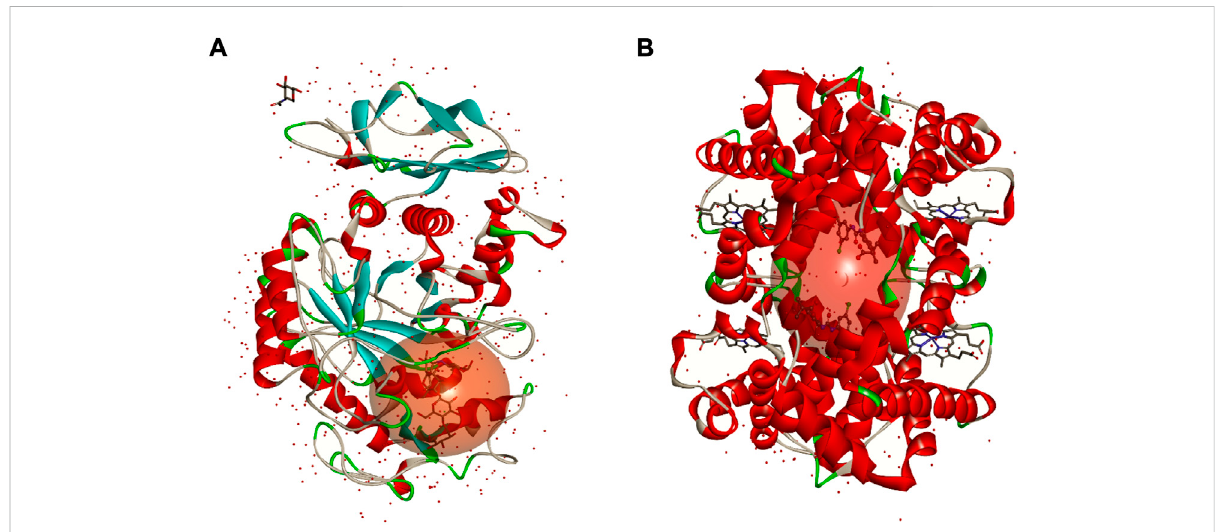
FIGURE 4 3D structures of α -amylase (A) and human haemoglobin (B) . The sphere in red represents the active site of each protein.